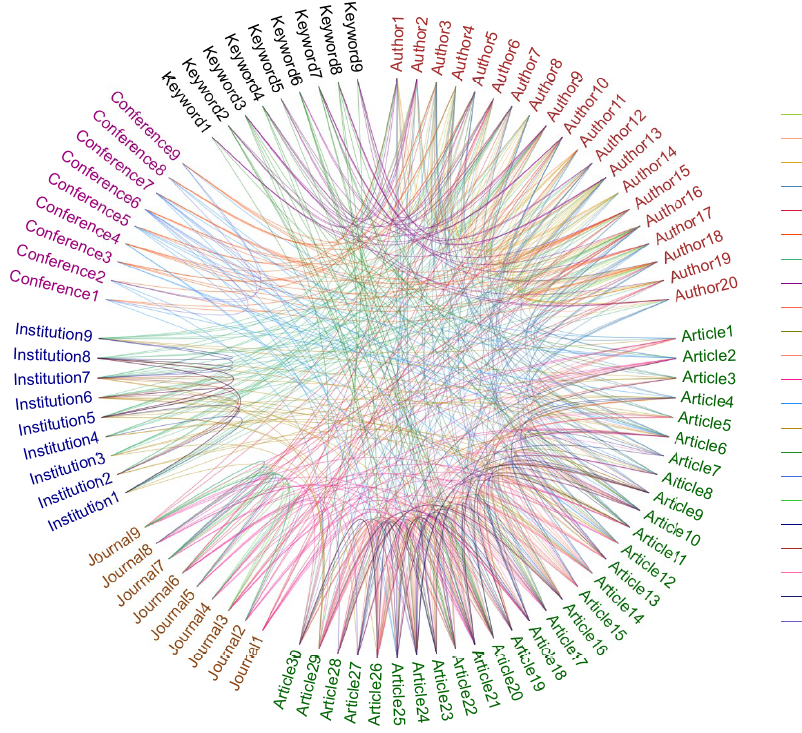
Figure 2. Characterizing scholarly